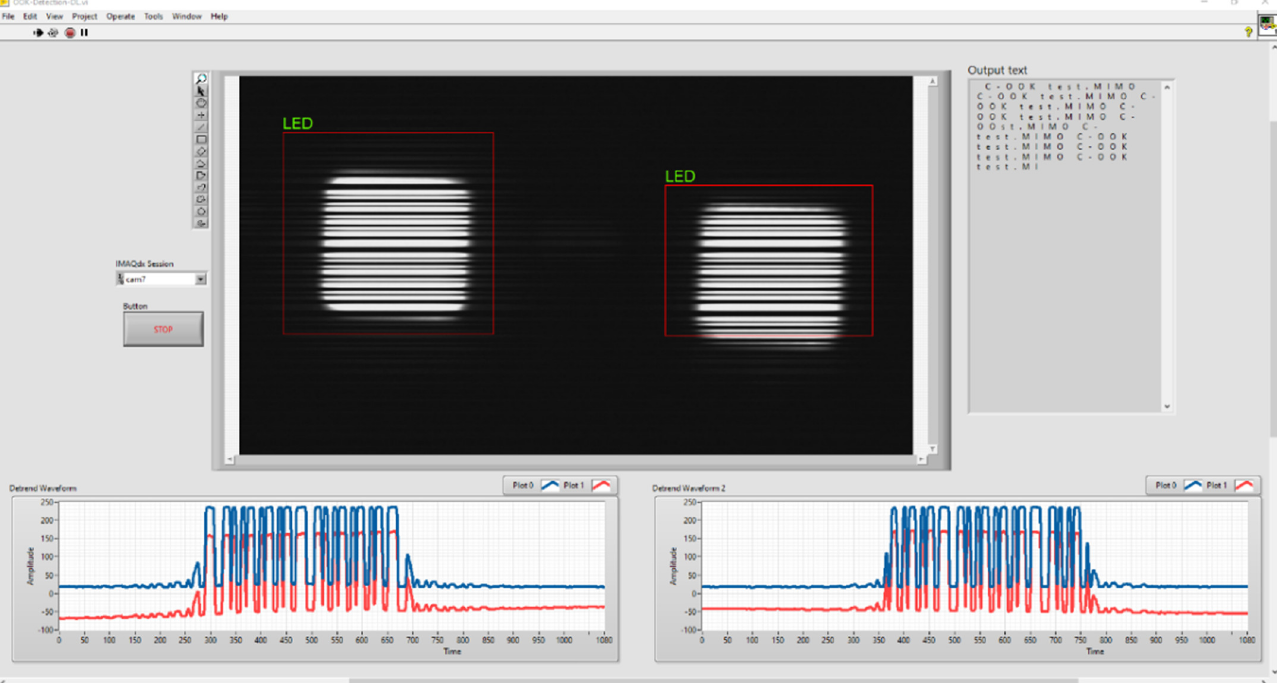
Figure 16. The receiver interface.